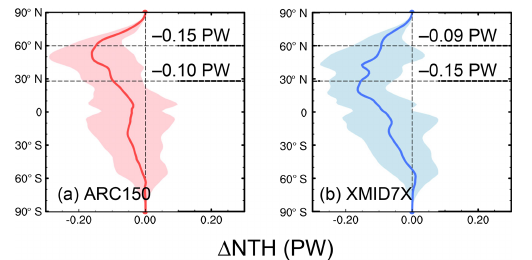
Figure 3. Zonal mean of changes in annual mean northward heat transport (NHT, PW) for ARC150X (a) and MID7X (b) compared to PD. Values of changes in NHT across 60 and 28 ◦ N are shown in each panel. The shaded areas represent 1 σ for 80 annual means. Figure 4.